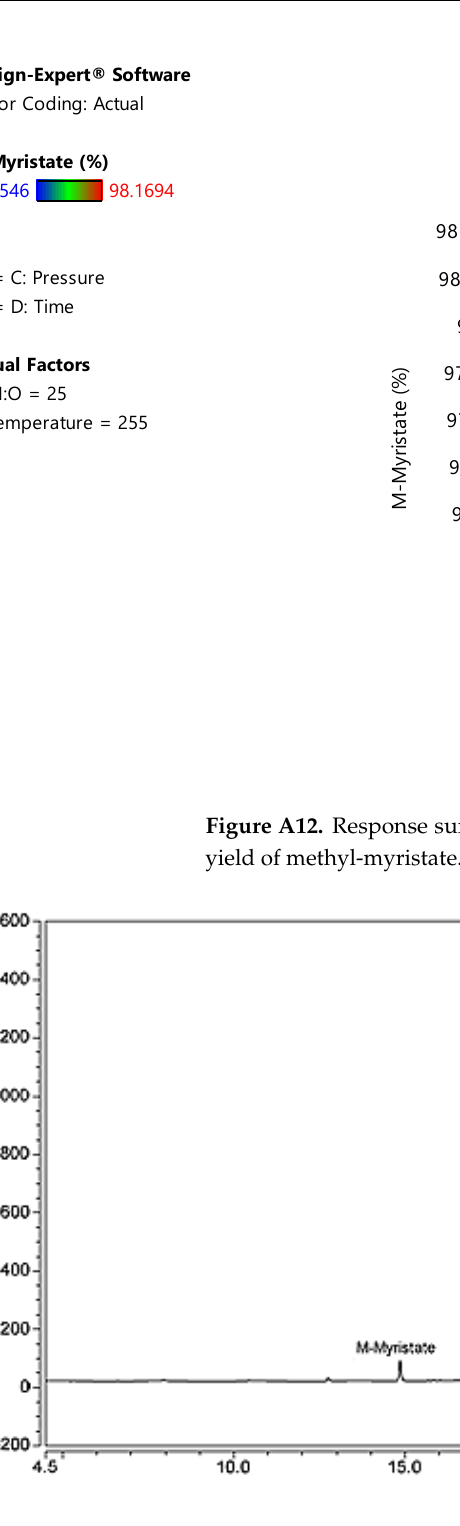
Figure A13. Chromatographic results of the derivatised WCO.